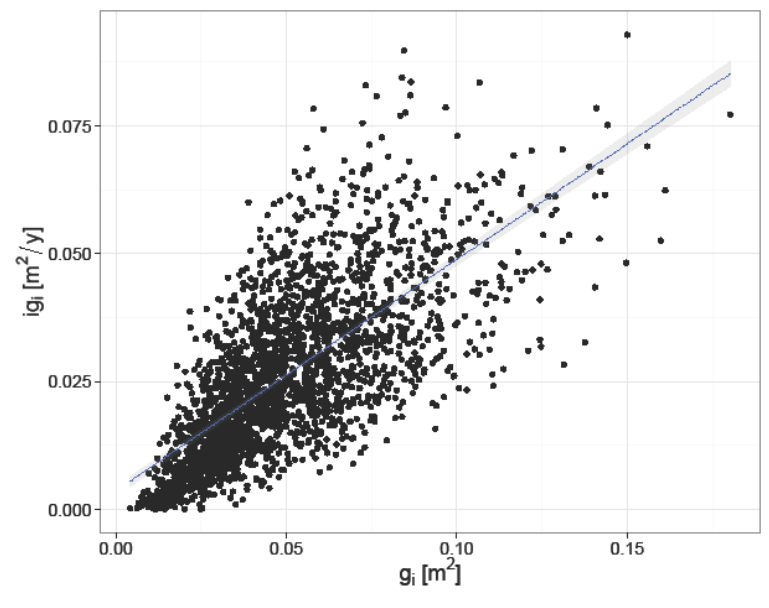
Figure 4. Relation between initial basal area ( g i ) and basal area increment ( ig i ) of individual